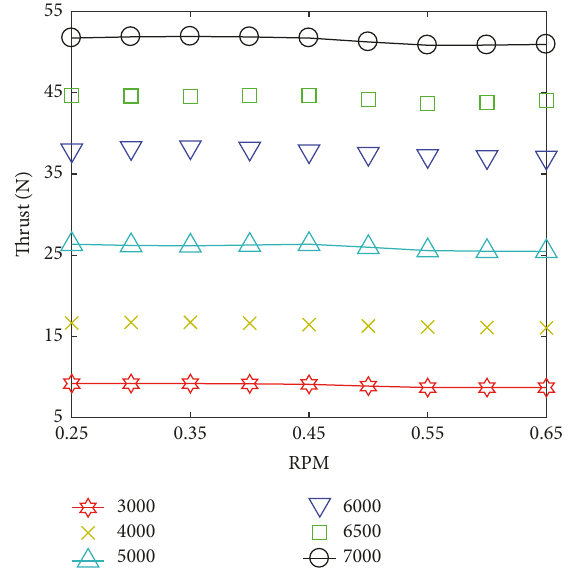
Figure 9: Experimental thrust versus rotor spacing.